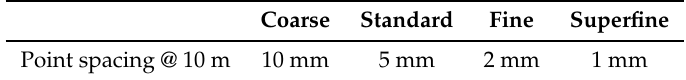
Table 3. Point spacings achievable with the Trimble SX10 depending on scanning